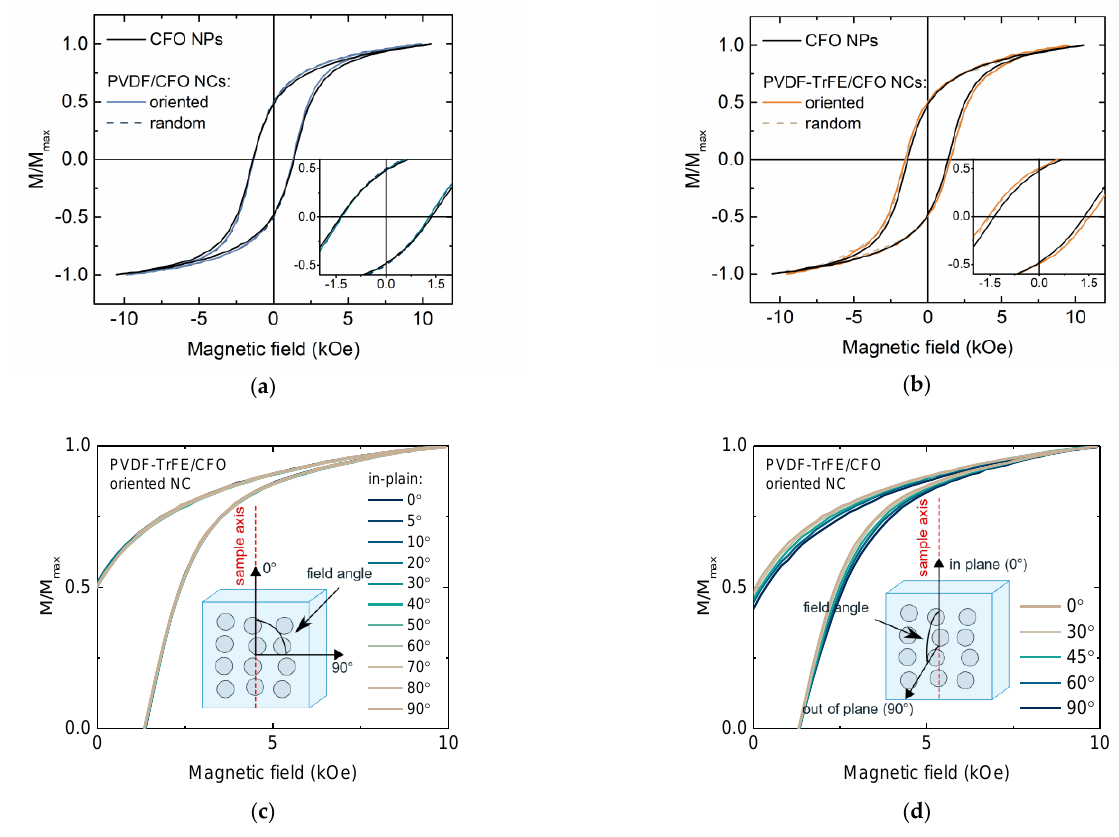
Figure 4. In-plane M-H loops reordered at 300 K for random and ordered ( a ) PVDF/CFO and ( b ) PVDF-TrFE/CFO nanocomposite compared with CFO NPs; M-H loops for ordered PVDF-TrFE/CFO sample as a function of sample axis and field direction in ( c ) in-plane and ( d ) from in-plane to out-of-plane